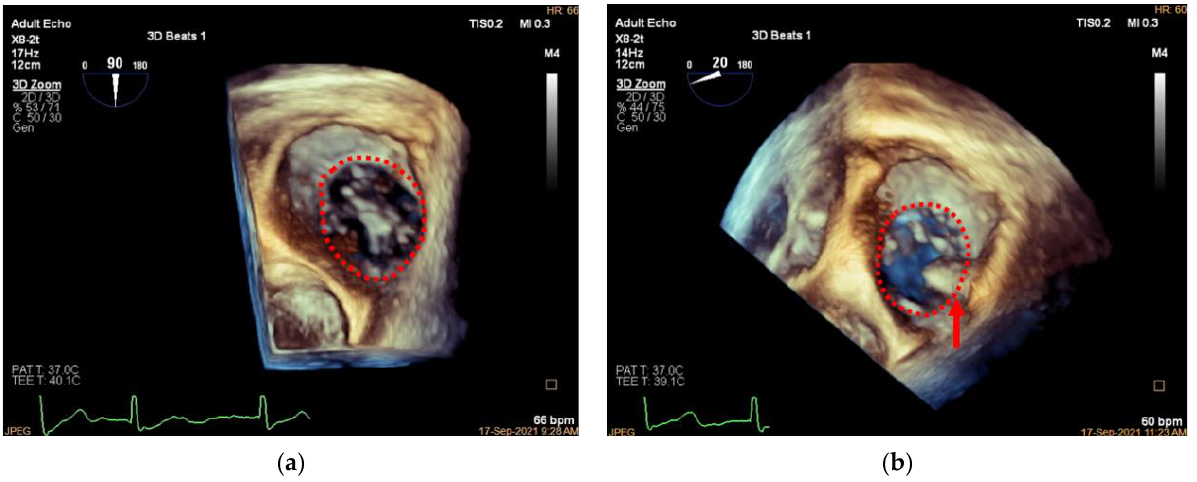
Figure 11. Three-dimensional comparison of TA morphology before and after K-Clip™ implantation. ( a ): Three-dimensional TEE work plane showing the TA morphology before annuloplasty; ( b ): the same view showing the TA (red dotted line) and clip position (red arrow) after intervention.